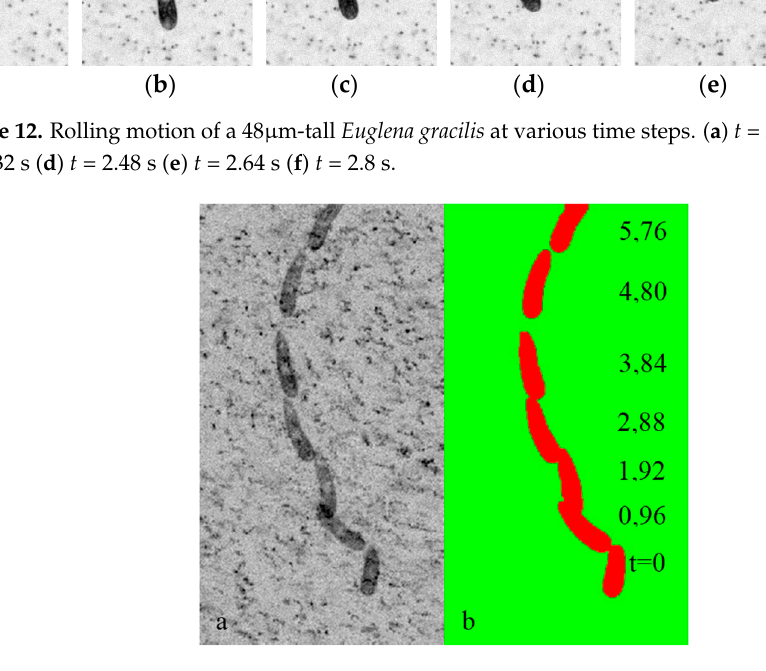
Figure 13. ( a ) Recorded position ( b ) dynamic mask of the 48 µm-tall E. Gracilis every 0.96 s.